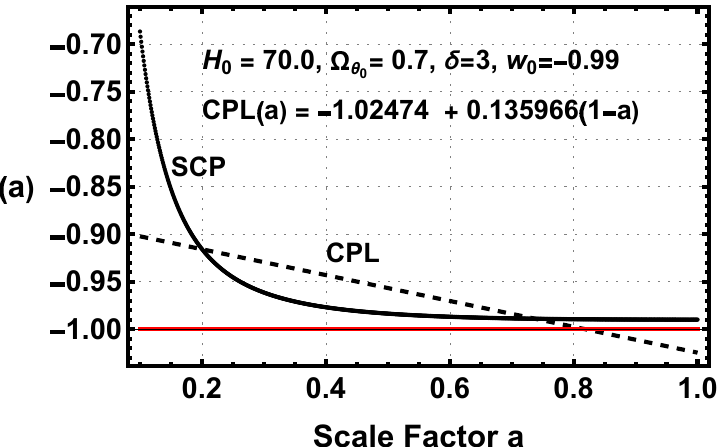
Figure 1. The dashed line is the CPL linear fit to the w ( a ) freezing evolution for w 0 = − 0.99, solid line. The linear CPL, dashed line, is a poor fit to the true evolution, solid line, and is